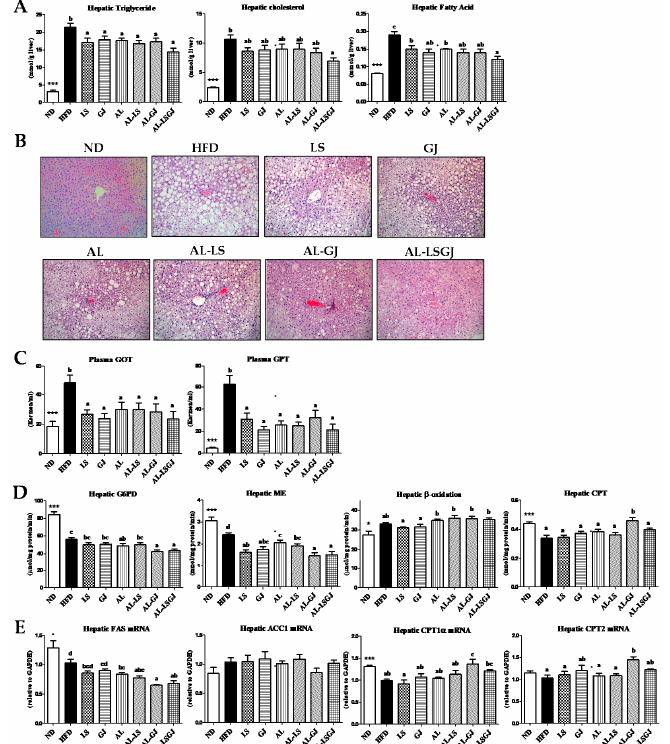
Figure 3. Effect of synbiotic supplementation for 12 weeks on hepatic morphology. ( A ) hepatic lipid levels, ( B ) hepatic morphology (X200), ( C ) hepatic lipotoxicity markers, ( D ) hepatic lipid regulating enzyme activities and ( E ) hepatic gene expressions in diet-induced obese mice. Data are mean ± S.E.; Significant differences ND versus HFD are indicated; * p < 0.05, *** p < 0.001; abc Means with different superscript letters are significantly different among the groups ( p < 0.05); ND: normal diet (5% fat, w / w ); HFD: high fat diet (20% fat, 1% cholesterol, w / w ); LS: HFD + Lactobacillus sakei LS03 10 9 cfu/day; GJ: HFD + Leuconostoc kimchi GJ2 10 9 cfu/day; AL: HFD + 3% allulose; AL-LS: AL + Lactobacillus sakei LS03 10 9 cfu/day; AL-GJ: AL + Leuconostoc kimchi GJ2 10 9 cfu/day; AL-LSGJ: AL + Lactobacillus sakei LS03 + L. Leuconostoc kimchi GJ2 10 9 cfu/each/day; GOT: glutamic oxaloacetic transaminase;